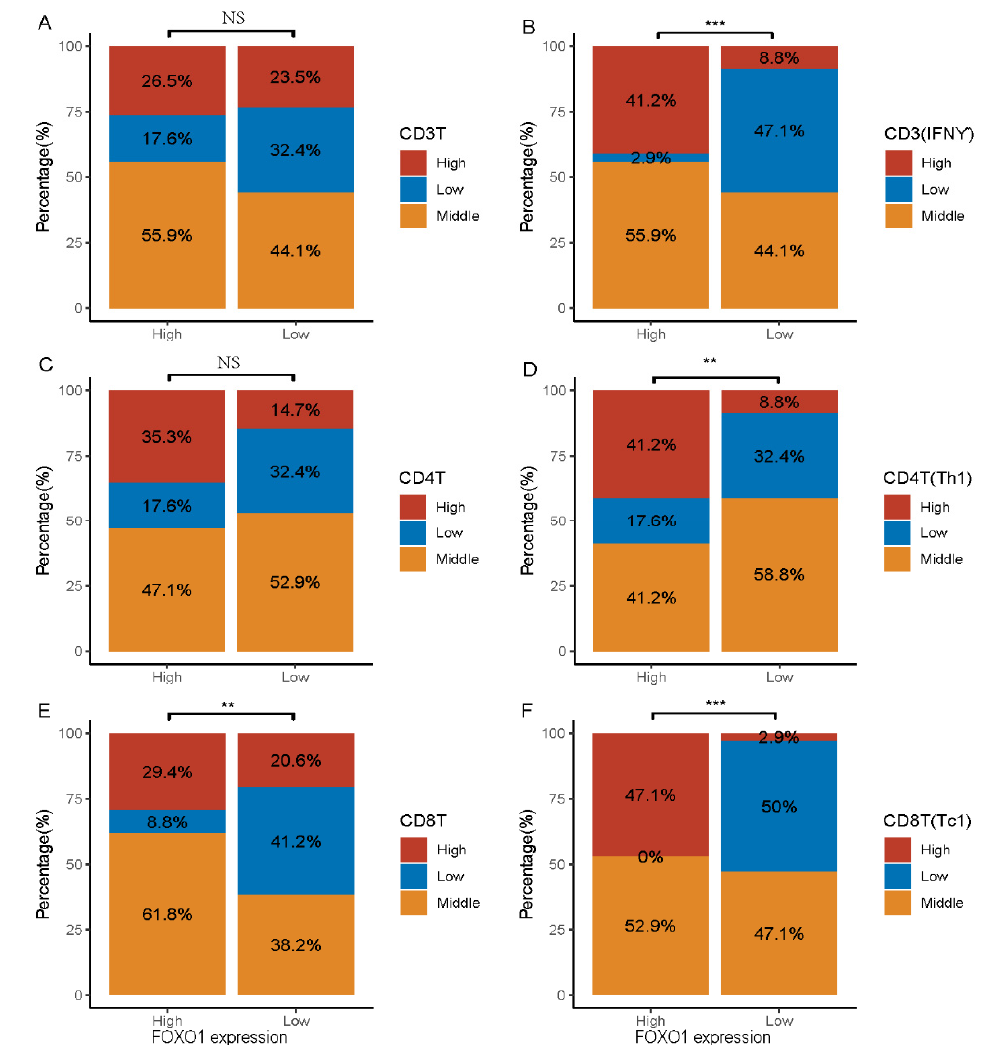
Figure 3. Effects of FOXO1 expression on immune cell distribution. FOXO1 expression higher than median value was defined as high expression, and FOXO1 expression less than median value was defined as low expression. Immune cell values higher than 75% range were defined as high expression, immune cell values between 75% to 25% range were defined as middle expression, and immune cell values below the 25% range were defined as low expression. We compared the percentage of low-, medium-, and high-expressing immune cells in the FOXO1 low- and high-expressing groups, respectively. ( A ) showed proportion of highly CD3T was high in MDS with high expression of FOXO1 relative to MDS patients with low expression of FOXO1, but not statistically significant. ( B ) displayed a significantly higher proportion of CD3T(IFN Ƴ ) cells high expression in MDS with high expression of FOXO1 relative to MDS patients with low expression of FOXO1. ( C ) demon- strated MDS with high expression of FOXO1 had a higher proportion of high CD4T than those with low FOXO1 expression, but it was not statistically significant. ( D ) demonstrated the proportion of highly expressed CD4T(Th1) was significantly higher in the high FOXO1 expressing group than in the low FOXO1 expressing MDS patients. ( E ) illustrated the proportion of highly expressed CD8T was significantly higher in the high FOXO1 expressing group than in the low FOXO1 expressing MDS patients. ( F ) illustrated the proportion of highly expressed CD8T(Tc1) was significantly higher in the high FOXO1 expressing group than in the low FOXO1 expressing MDS patients. ** means p < 0.01, *** means p < 0.001. NS means no significance .